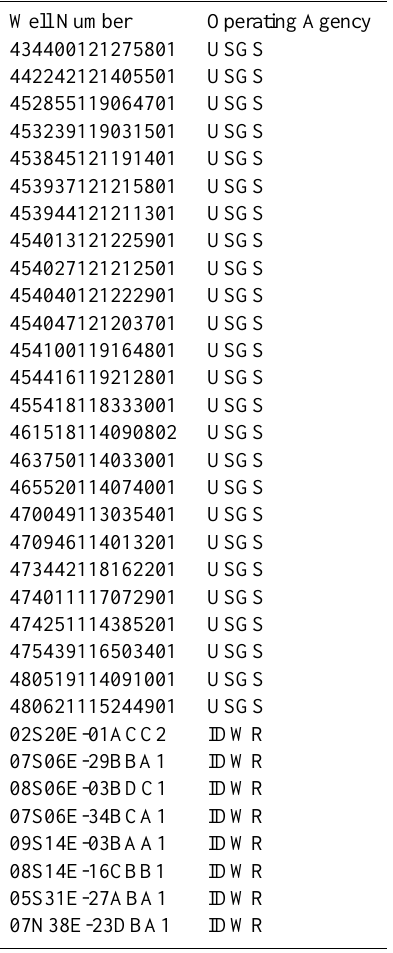
Table A2. The groundwater wells used in the analysis that compares GRACE-derived groundwater with location-specific wells. USGS is the United States Geological Survey and IDWR is the Idaho Department of Water